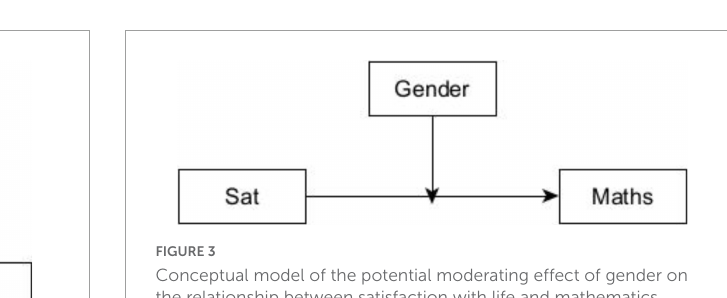
FIGURE2 Conceptual model of the potential mediating effects of instructional clarity and parental involvement on the relationship between satisfaction with life and mathematics achievement. ParInv, parental Involvement; InsClar, instructional clarity; Sat, satisfaction with life;